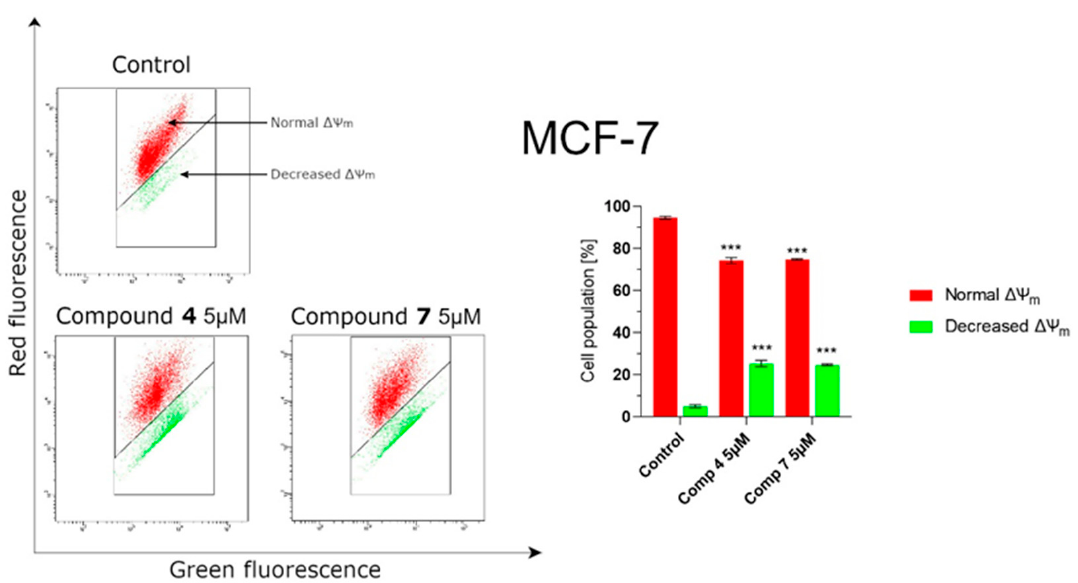
Figure 16. Flow cytometry analysis of mitochondrial membrane potential changes ( ΔΨ m ) in the MCF-